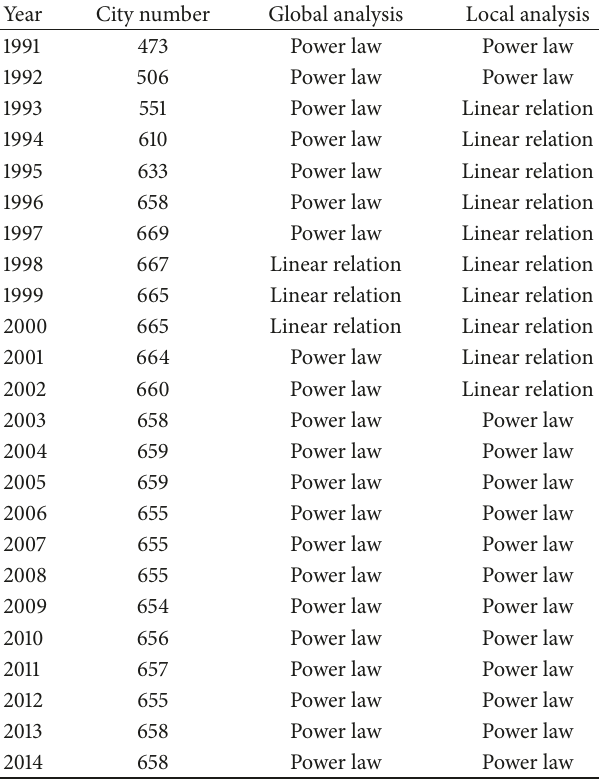
Table 3: The evolution of the allometric scaling in the hierarchy of Chinese cities (1991–2014).